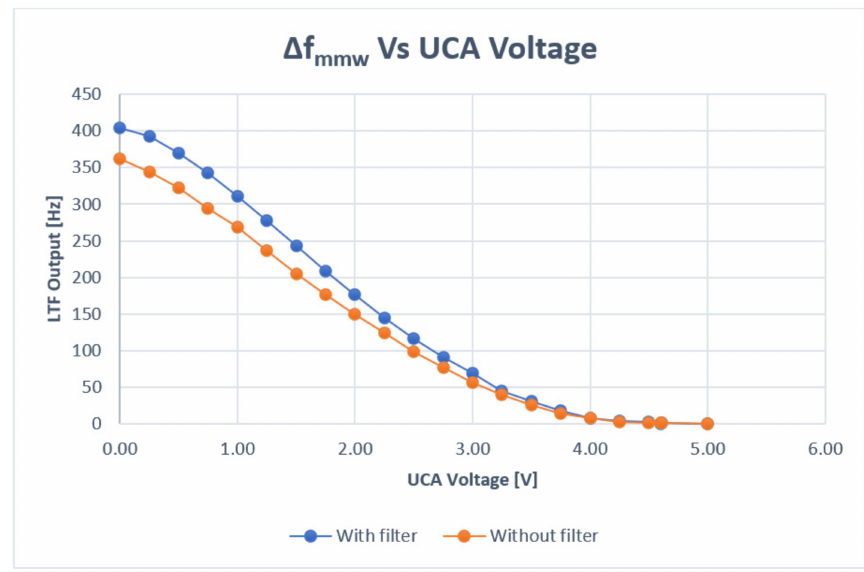
Figure 11. Variation in the output frequency of LTF in accordance to the UCA